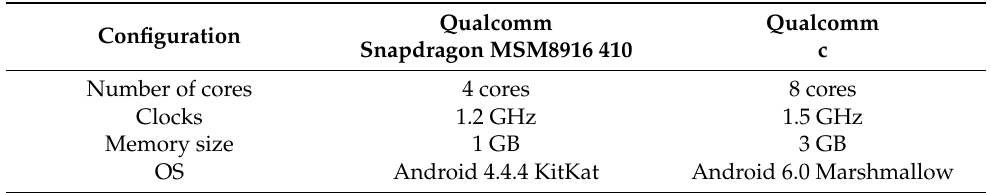
Table 1. This is the hardware configuration.